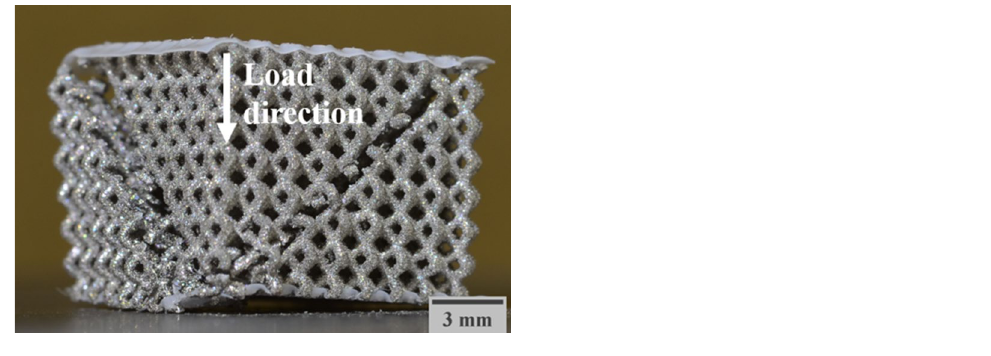
Figure 7. Fracture plane of the AB structure under compression load in